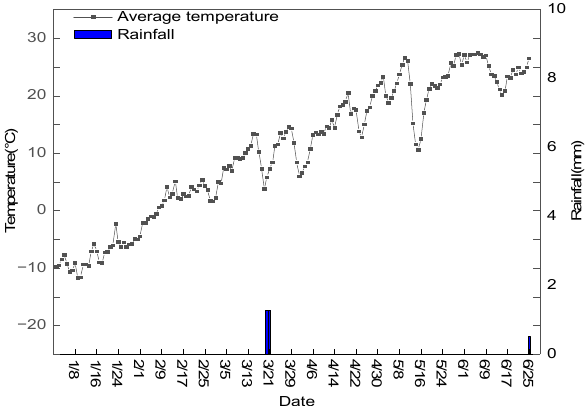
Figure 1. Daily precipitation and average temperature during the 2022 winter wheat growing season (National Meteorological Center of China).